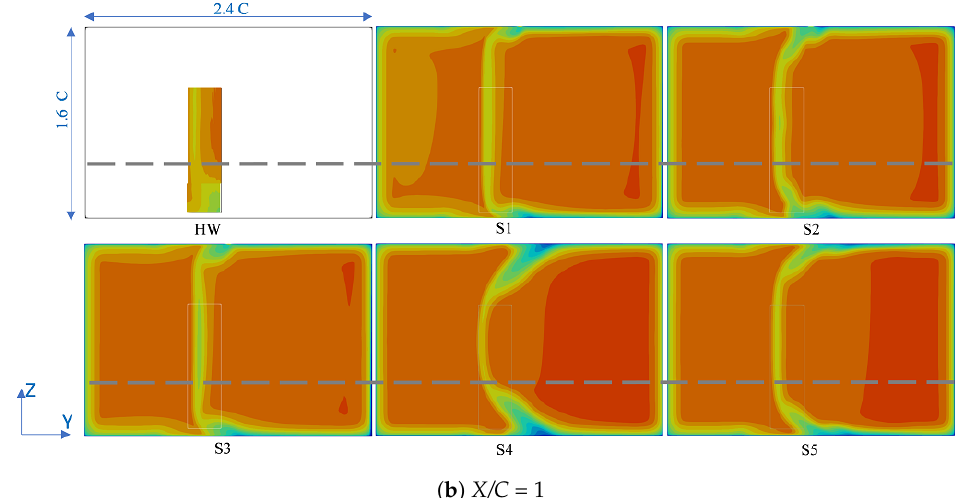
Figure 6. Spanwise development of the wakes at the planes normal to the flow: CFD vs. HW. Contours represent the mean flow velocity. The dashed lines show the separation height at HW. The panels are the YZ planes shown in Figure